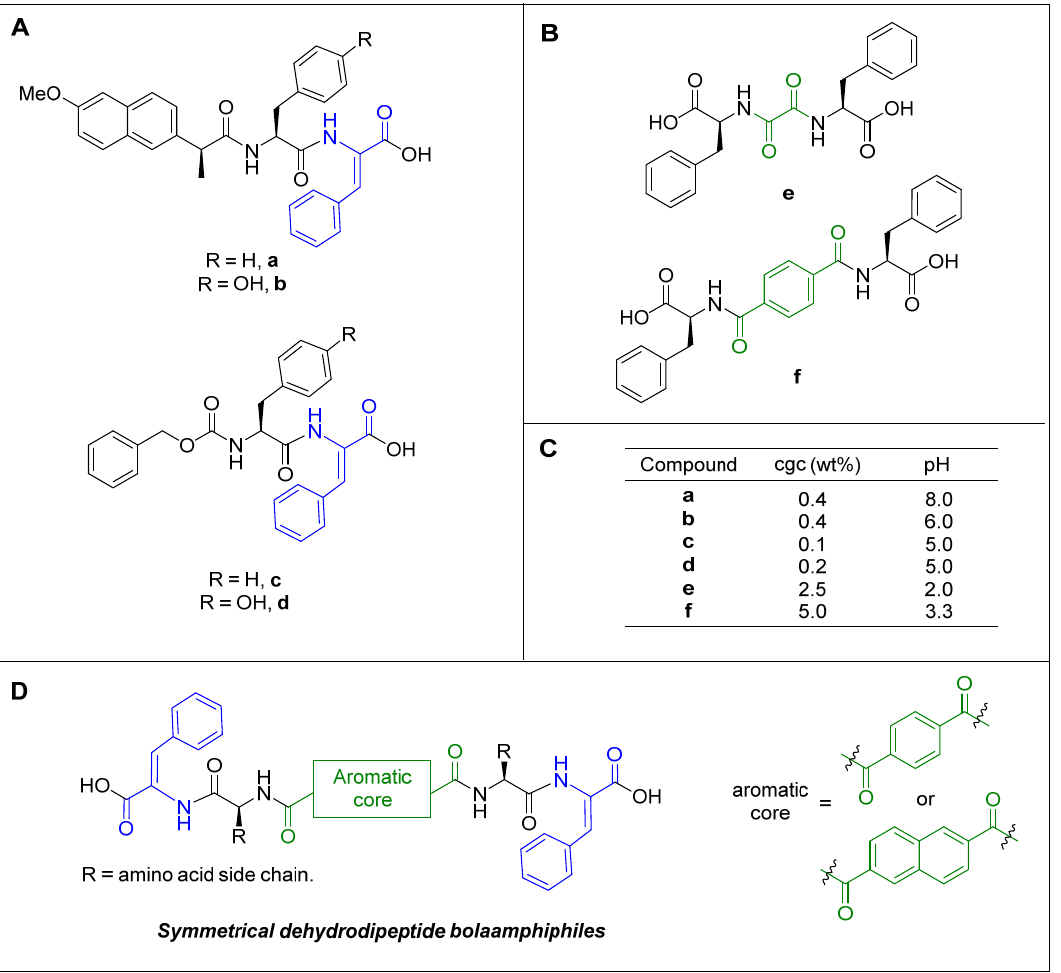
Figure 1. ( A ) Our previously studied naproxen- and carboxybenzyl-capped dehydropeptide hydrogelators. ( B ) Examples of bolaamphiphilic hydrogelators in the literature. ( C ) Summary of hydrogel properties. ( D ) Combining the structures of N -capped dehydrohydropeptide gelators and bolaamphiphilic gelators into a single molecule.